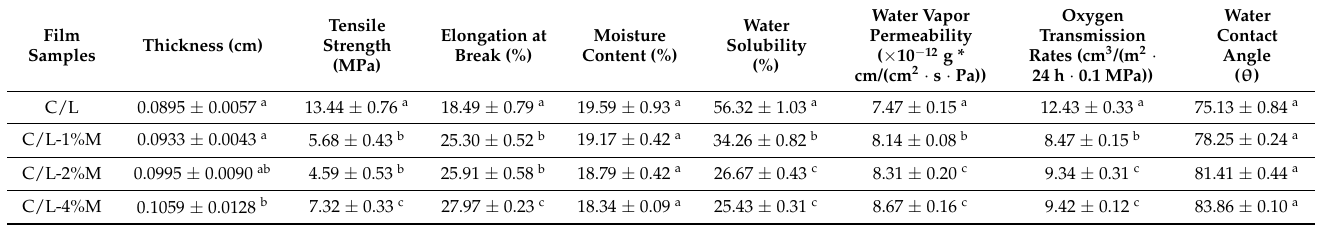
Table 1. The physical and mechanical properties of carboxymethyl chitosan/locust bean gum films incorporated with Melissa officinalis L. essential oil